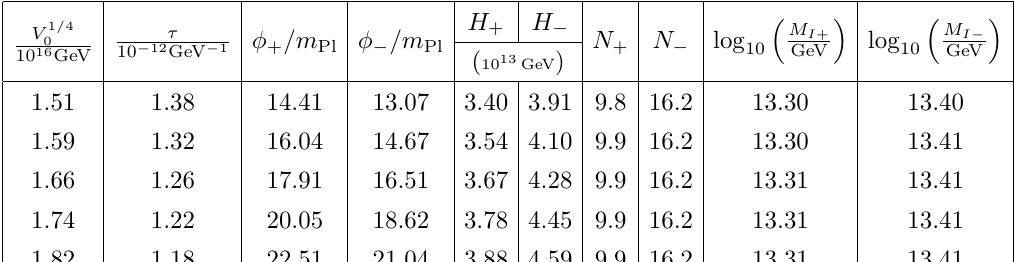
and their values (indicated by a I